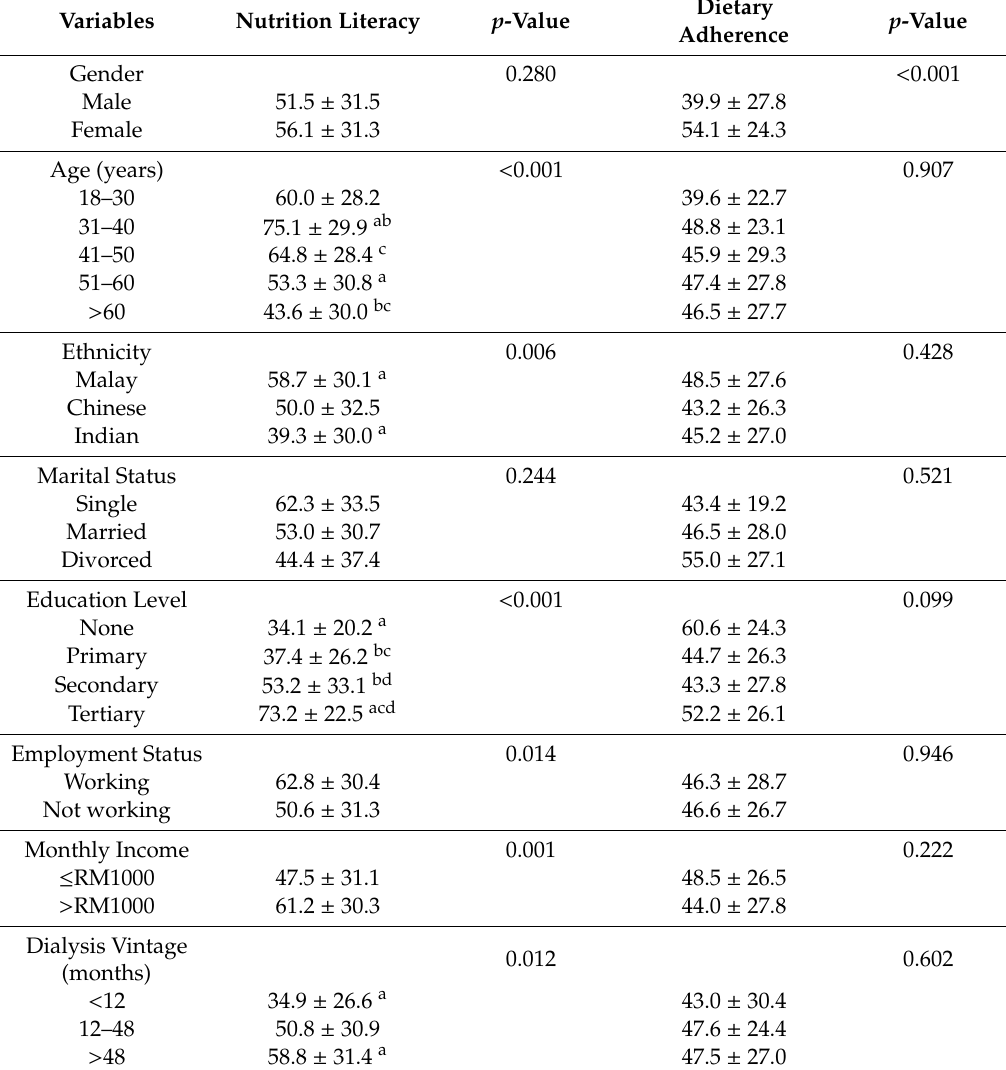
Table 2. Comparisons of Nutrition Literacy and Dietary Adherence across Patients’ Characteristics ( n =